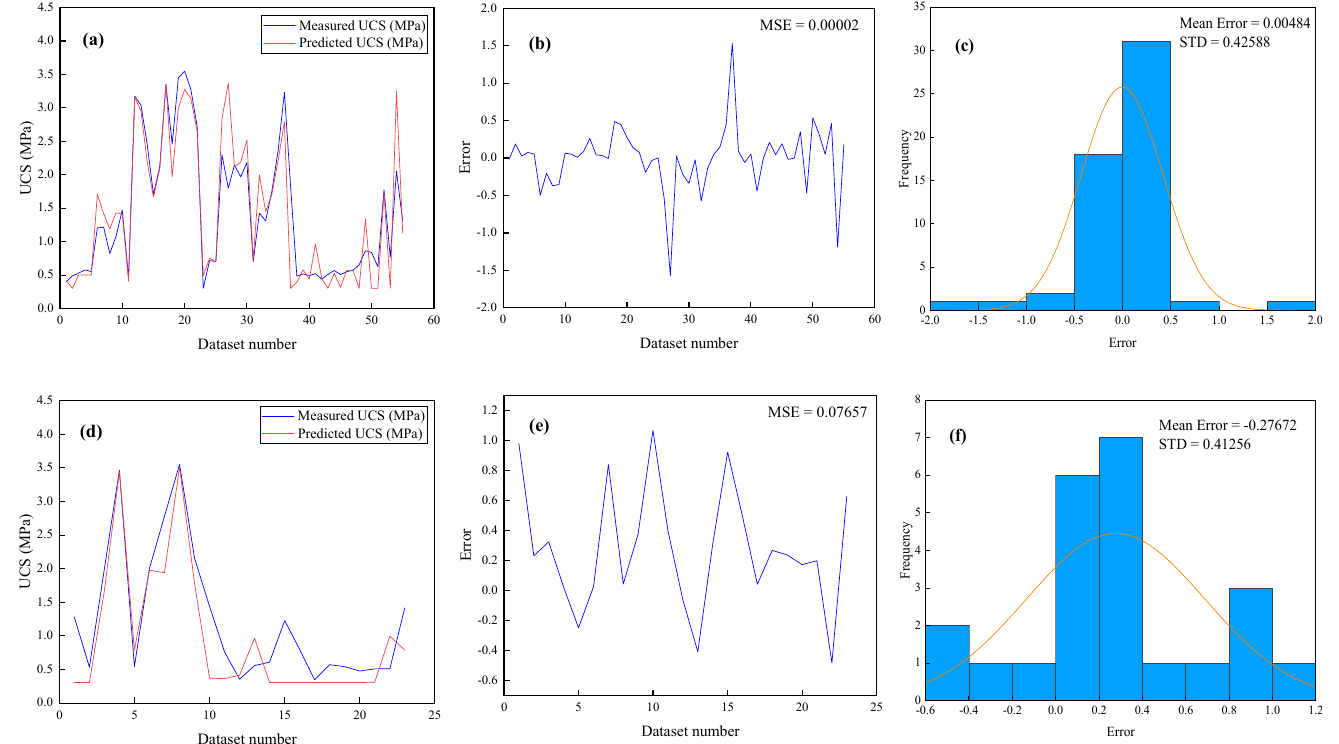
Figure 12. The demonstration of ANN model M2 for UCS. ( a ) The model M2 results aggregated with the measured UCS. ( b ) The variation in error between the measured and predicted values. ( c ) Error histogram for the training data and ( d ) model M2 results aggregated with the measured data. ( e ) The variation in error between the measured and predicted values. ( f ) Error histogram for the testing data.